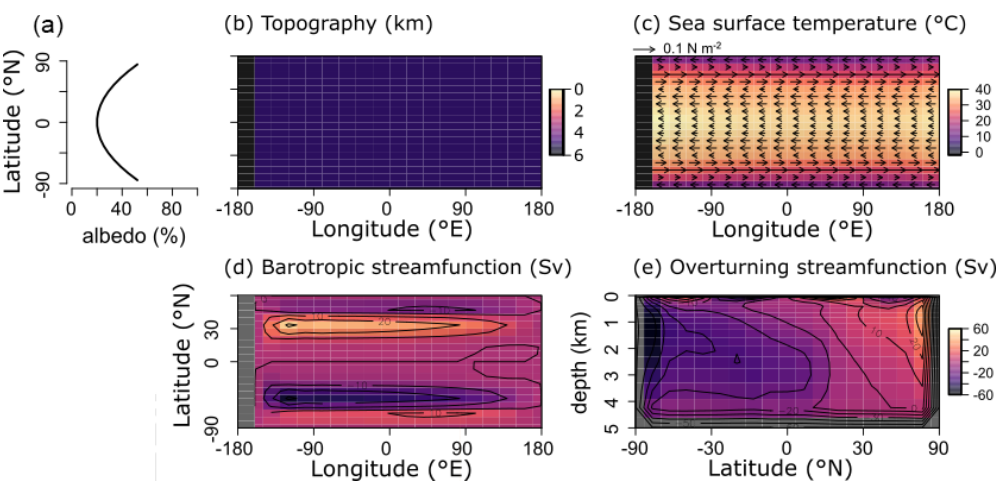
Figure 3. (a) Albedo, (b) topography, (c) sea surface temperature and wind stress, and (d, e) ocean circulation patterns for all model runs. (d) Barotropic streamfunction. (e) Overturning streamfunction. Positive values indicate clockwise